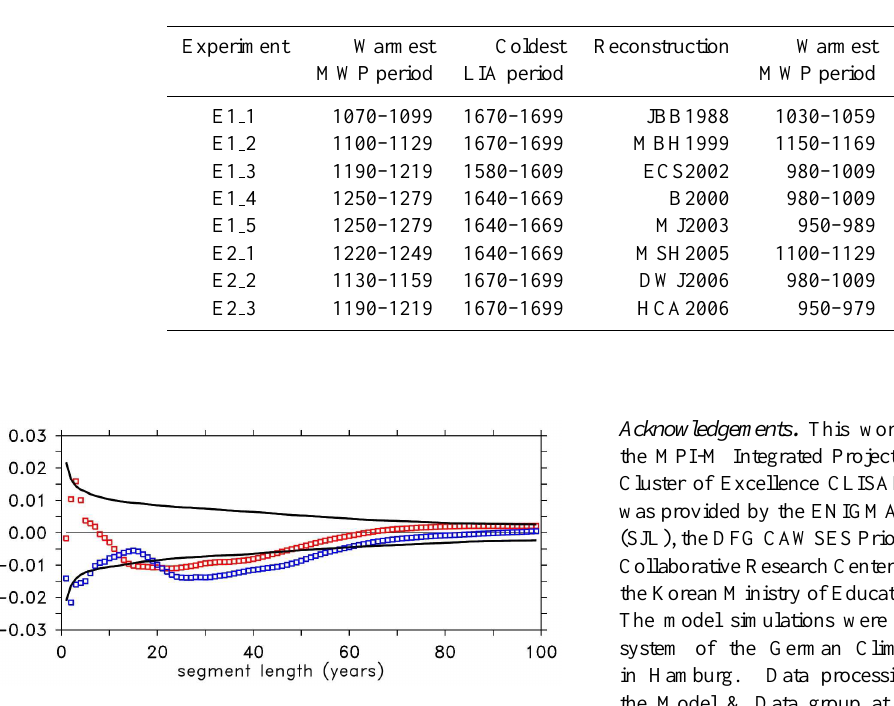
Fig. C1. Detection of significant trends in the time series for a par- ticular start date (1400AD): black lines indicate the 5th–95th per- centile of the various trend lengths derived from the 3000-year con- trol run. Coloured lines are trends from NH temperature time series from two forced runs (red: expt. E1 5 (weak solar), blue: expt. E2 3 (strong